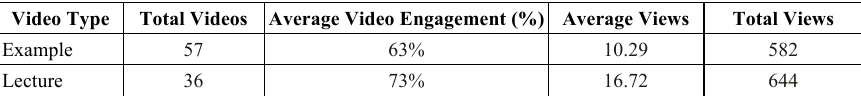
Table 2. Lecture, Example video